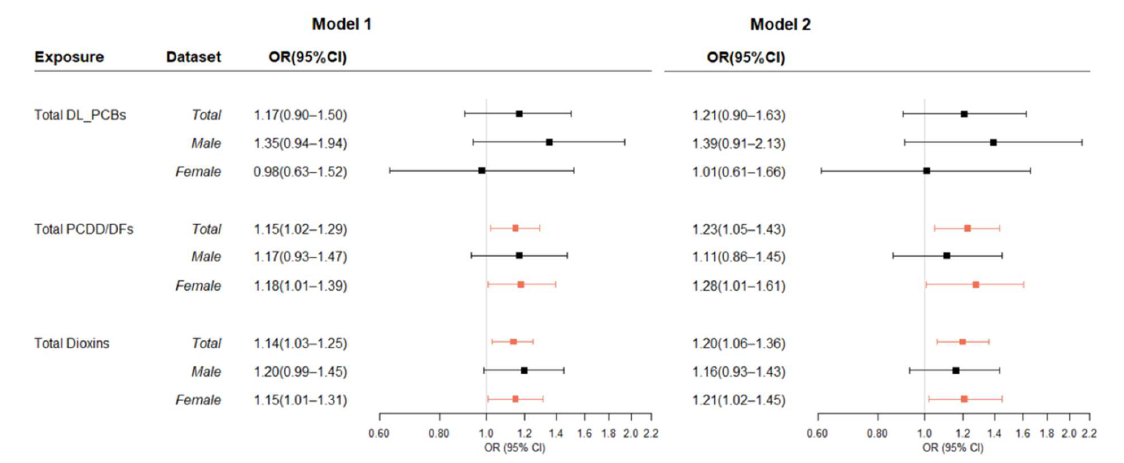
Figure 2. Odds Ratios of blood concentrations of PCDD/DFs, DL-PCBs (pgTEQ/g_lipid) and Type 2 Diabetes mellitus. OR, odds ratio; CI, confidence interval; Model 1: Adjusted for age and sex; Model 2: Adjusted for the model 1 variables, body mass index, systolic blood pressure and high-density lipoprotein. Marked red based on statistically significant results.